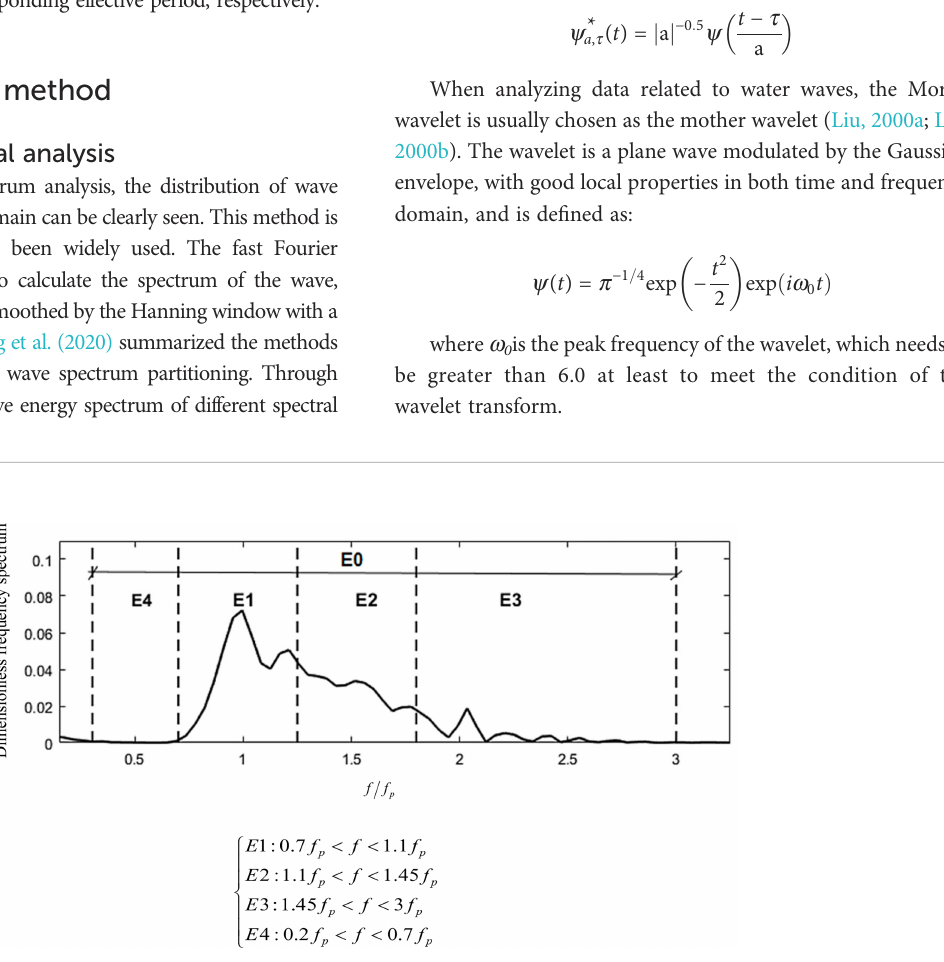
FIGURE 4 Energy spectrum partition proposed by Abroug et al.